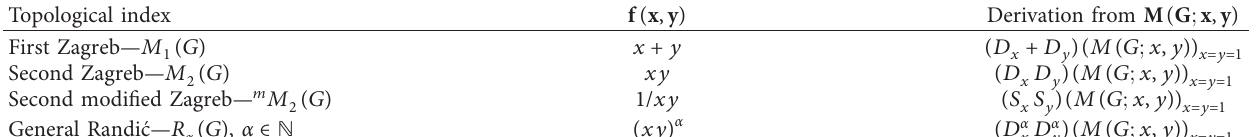
Table 1: The derived formulas to compute some degree-based topological indices from M -polynomial [18]. Topological index